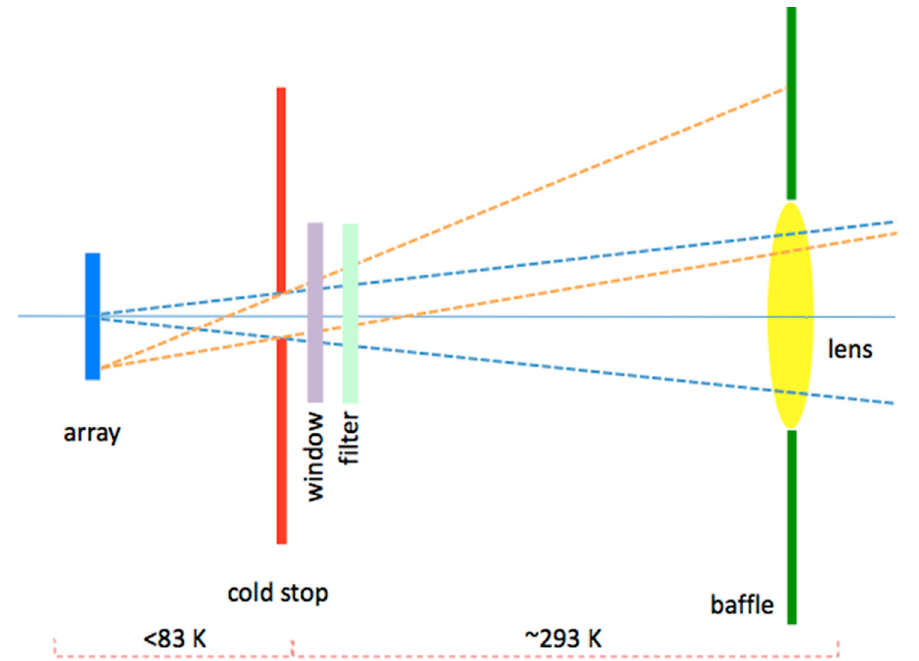
Figure A1. Raytrace schematic of the CTI optical model with detector array and telescope to illustrate the vignetting effect projected onto the detector array. The thermal emission of the optical components under the ambient environment contributed significantly to the CTI signals and needed to be adequately modeled to derive the observed radiance from Earth’s scenes. The flat-field algorithm was developed to correct thermal contributions from these frontend optical elements in the telescope (see